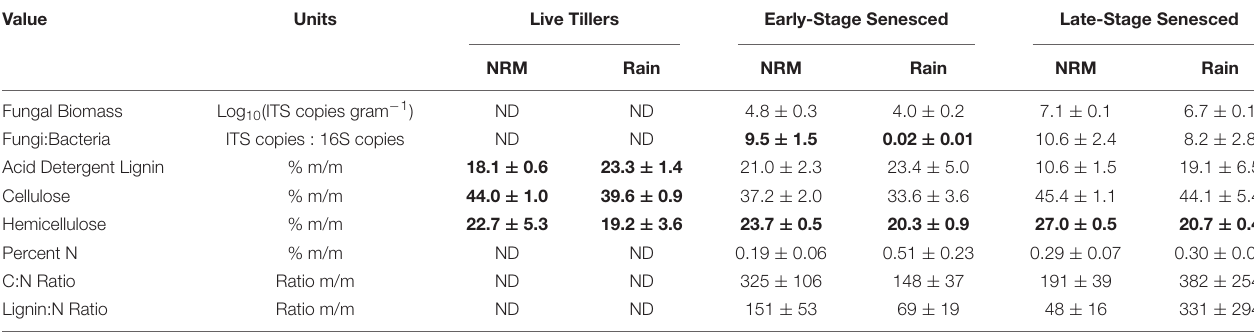
TABLE 2 | Fungal biomass, fungal:bacterial ratios, and litter chemistry values for live S. sabulicola tillers and standing dead litter at both sites. Value Units Live Tillers